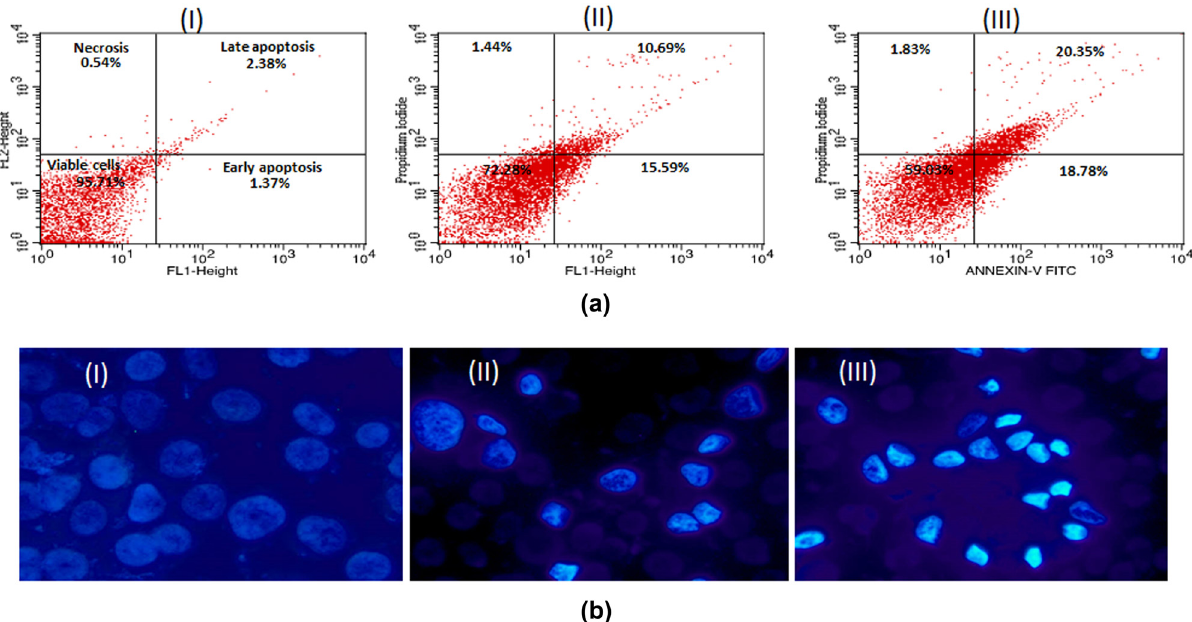
Figure 8: ( a ) Flow cytometry pro fi le of annexin V - FITC/PI staining of MCF - 7 cells showing percentage of viable cells, early apoptosis, late apoptosis, and necrotic cells. ( I ) Control, ( II ) 5 μ g/mL of AuNPs, ( III ) 10 μ g/mL of AuNPs. ( b ) Representative images of AuNPs - treated MCF - 7 cells captured under fl uorescence microscope after staining with nuclear dye Hoechst 33324. ( I ) Control, ( II ) 5 μ g/mL, ( III ) 10 μ g/mL. Magni fi cation 200 × .